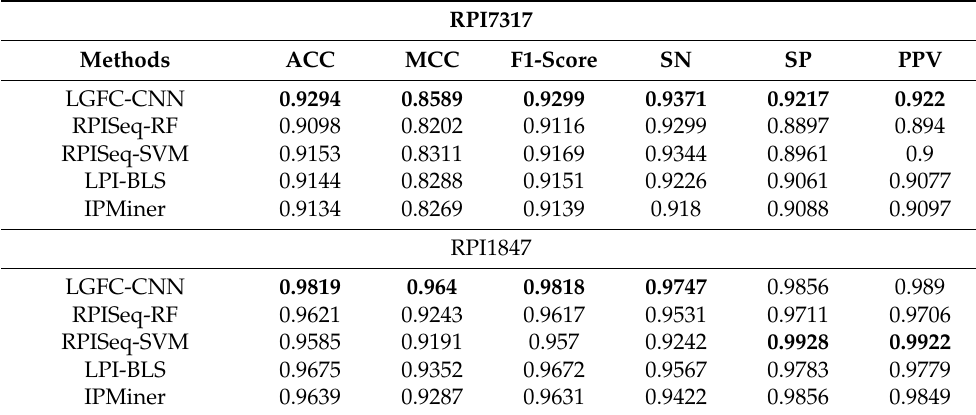
Table 3. The result of LGFC-CNN and other four methods on the RPI7317 and RPI1847 datasets.